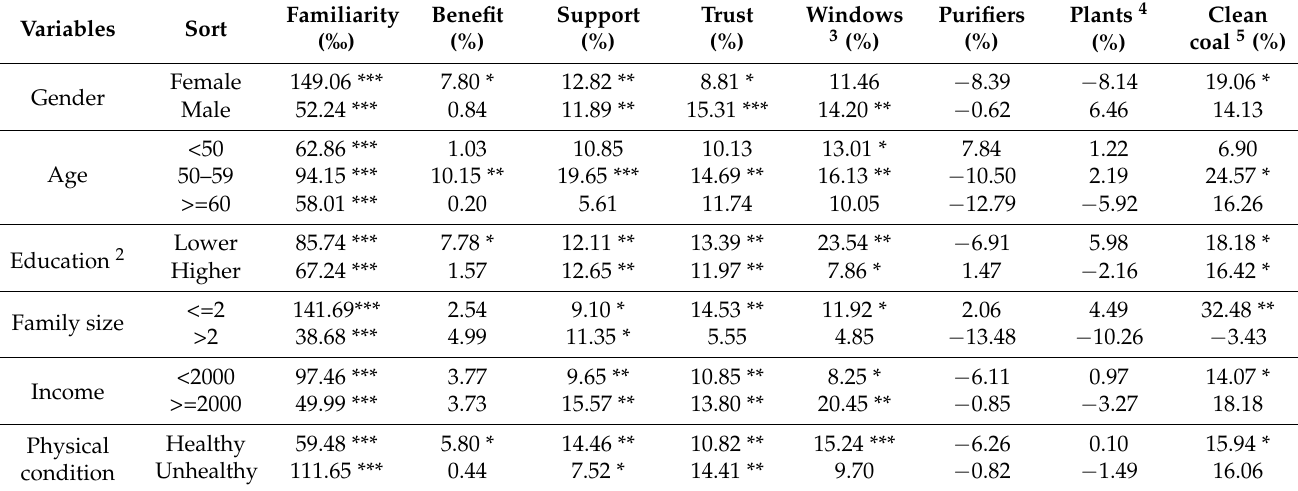
Table 3. Increase ratio in case group compared to control group 1 .